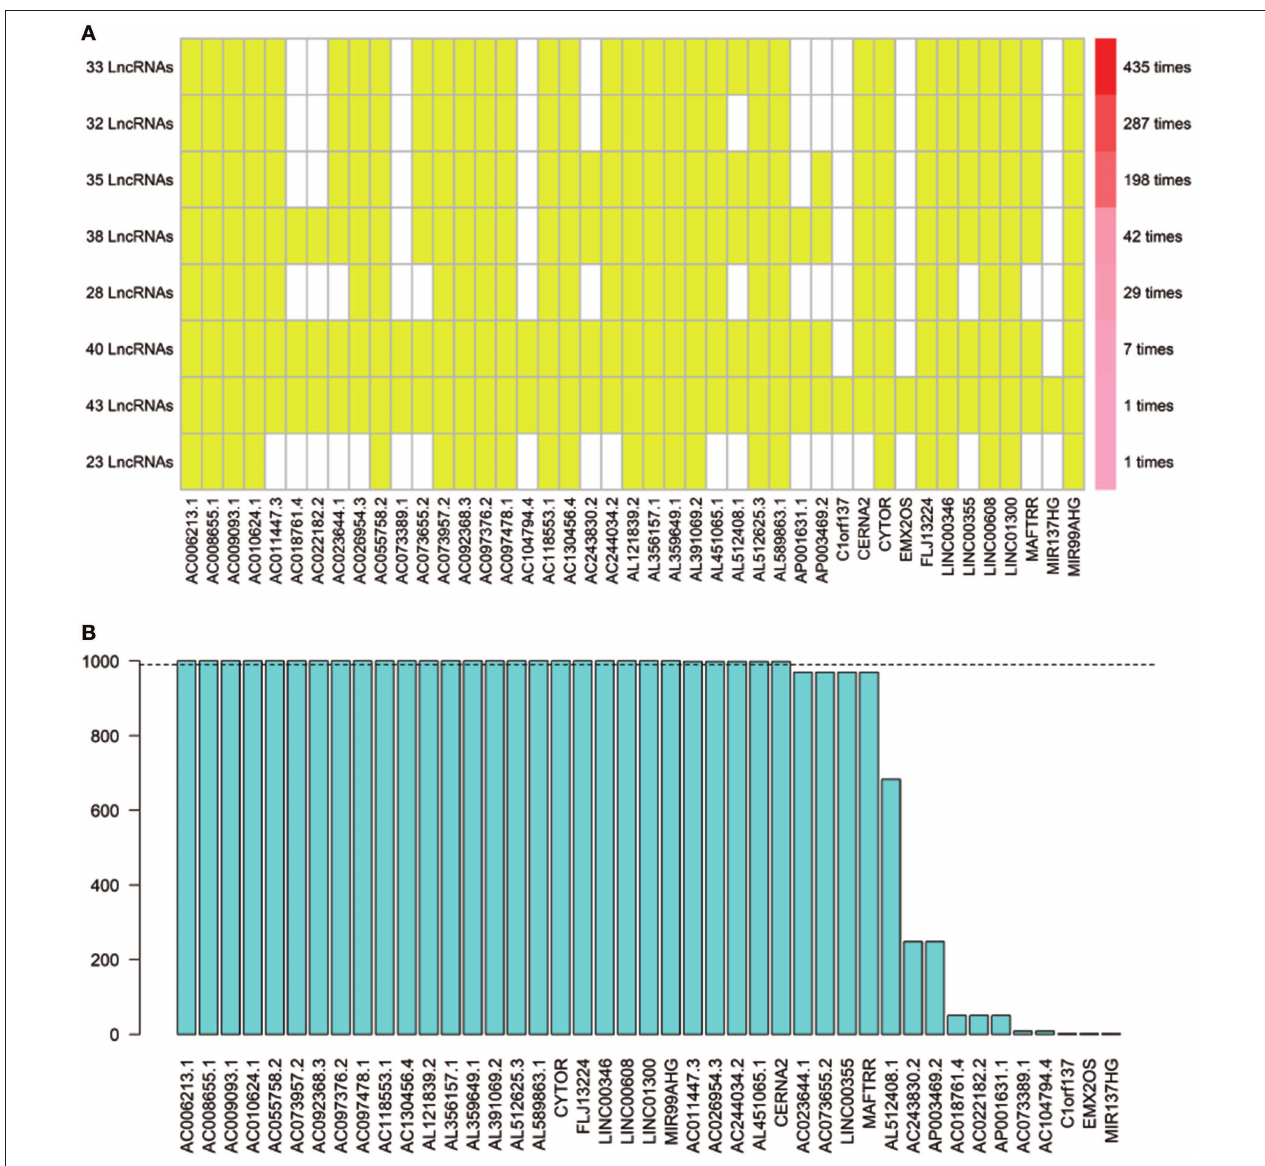
FIGURE 2 | The seed lncRNAs were extracted by 1,000 times Cox LASSO regression. (A) Highly consistency was demonstrated in the lncRNAs among the 8 extracted lncRNA sets. The left ordinate indicates the seed lncRNA set and the number of seeds lncRNAs found by every single iteration of LASSO. The right ordinate is the frequency of the seed lncRNA set disclosed through the 1,000 times Cox LASSO regression. The horizontal ordinate is the lncRNA name. The yellow block represents the occurrence of the particular lncRNA in the specific lncRNA set; (B) Totally 28 seed lncRNAs with > 990 occurrences in the most common lncRNA set were filtered out for further analysis. The blue column indicates the frequency of each lncRNA occurs in the most common lncRNA set.